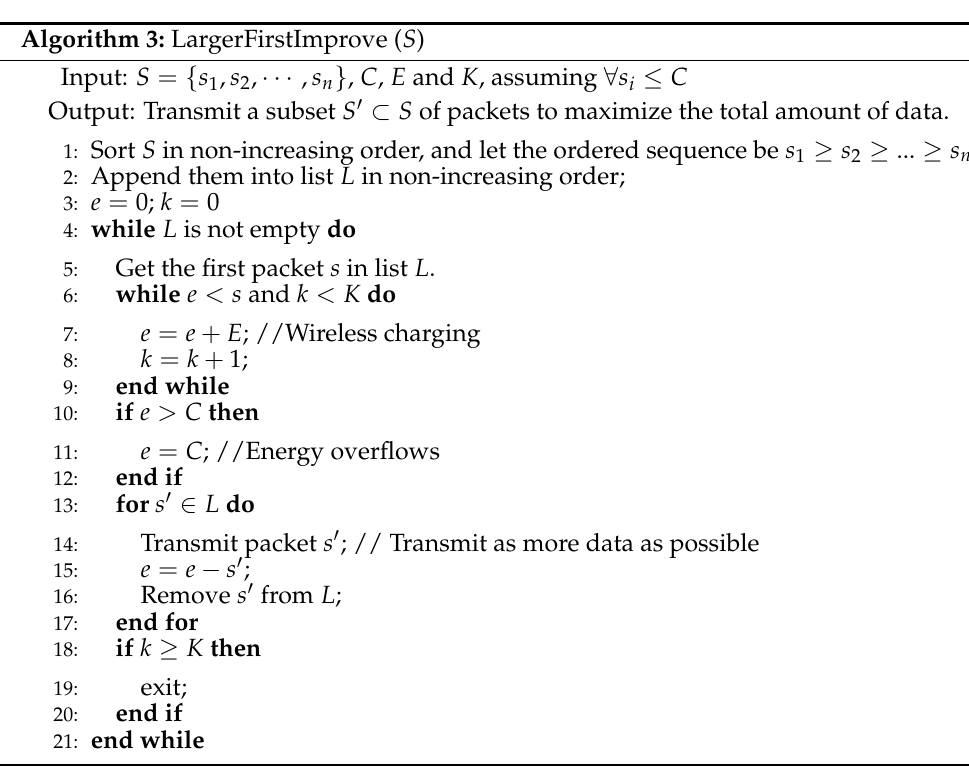
Algorithm 3: LargerFirstImprove ( S